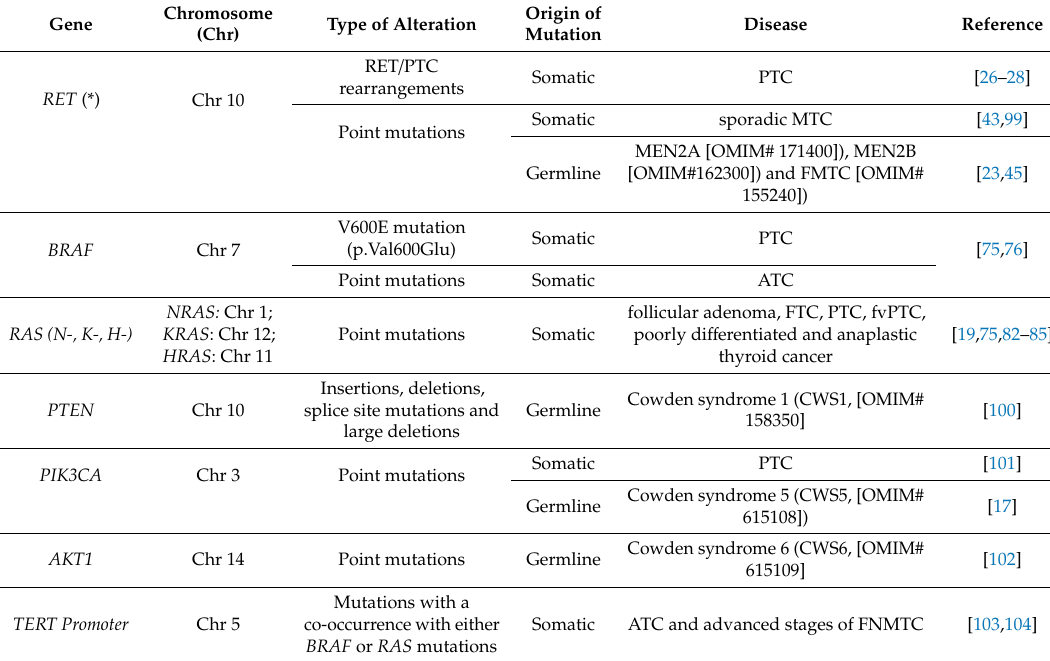
Table 2. Most relevant genes in thyroid